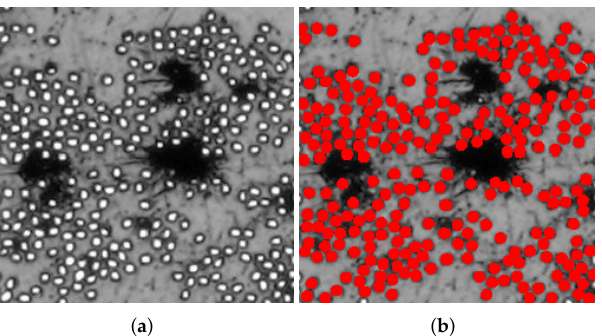
Figure 6. Application of the proposed algorithm in a cropped region of specimen TE-0-1-1: ( a ) repro- duction of a cropped region from original micrograph used for computing the microstructure and ( b ) computed microstructure using the proposed algorithm. The computed fiber volume fraction is V f =